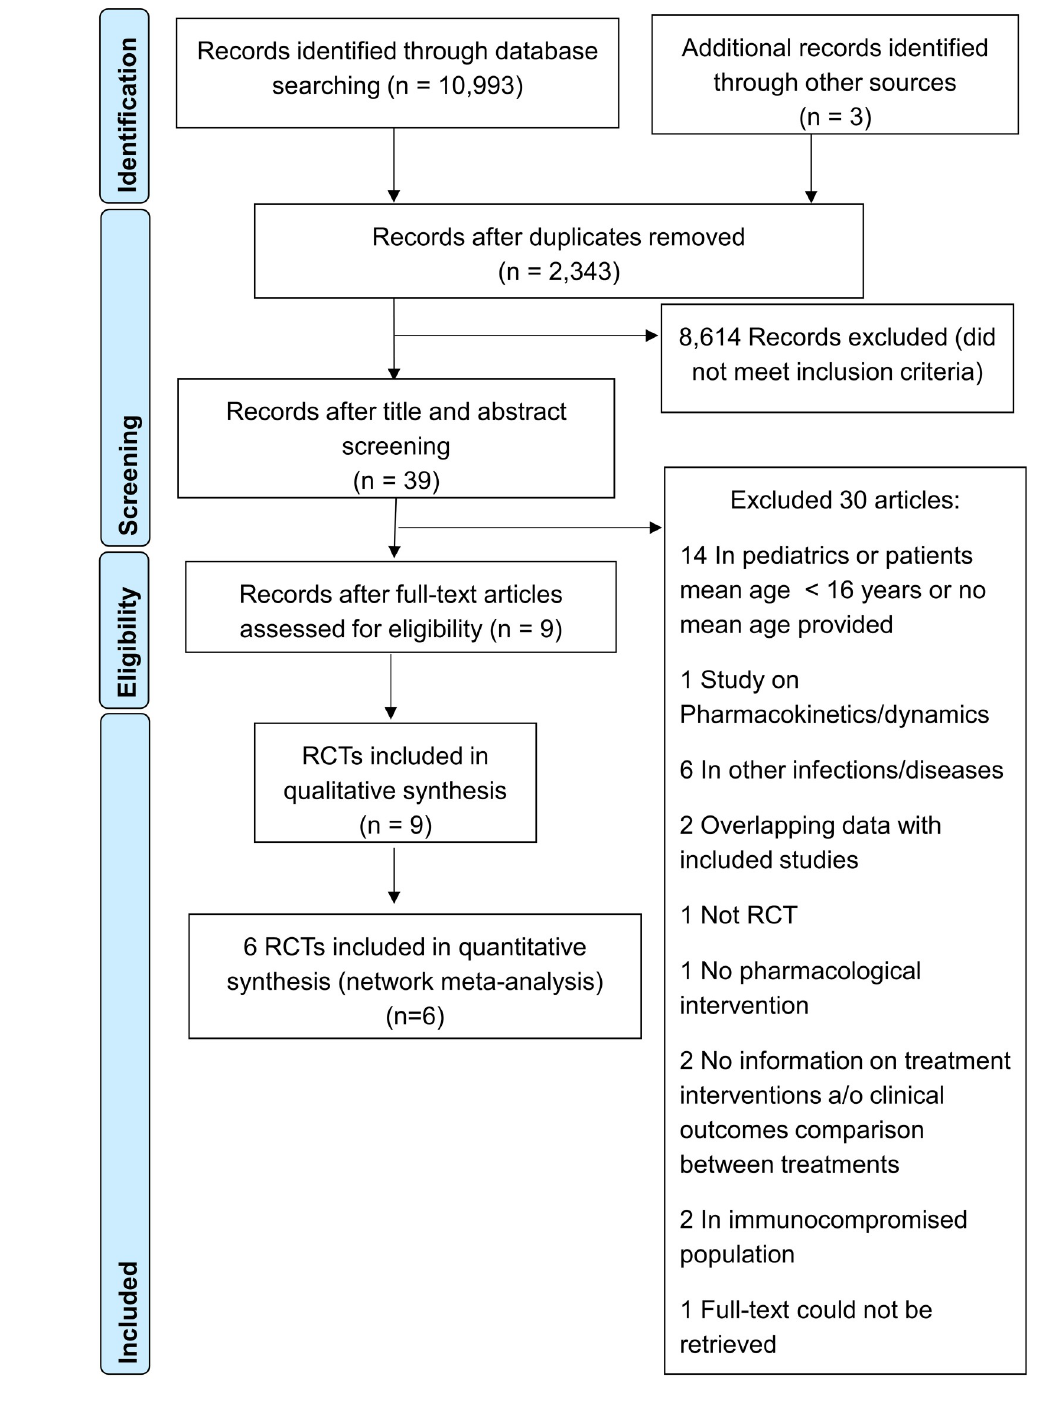
Fig 1. PRISMA flow chart of study selection process.